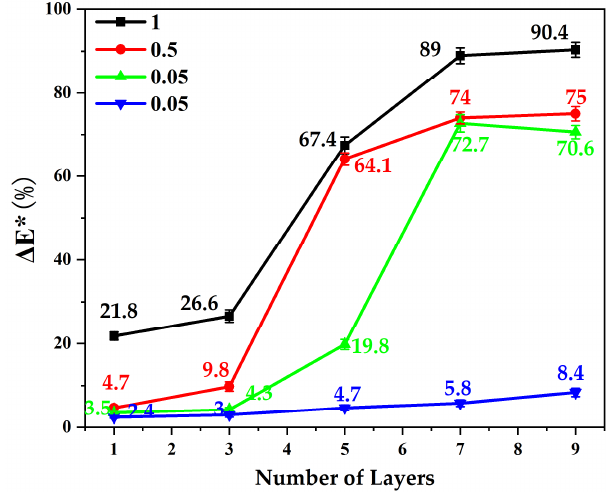
Figure 12. Color difference of the sandstone surface varies with the concentration of solutions.